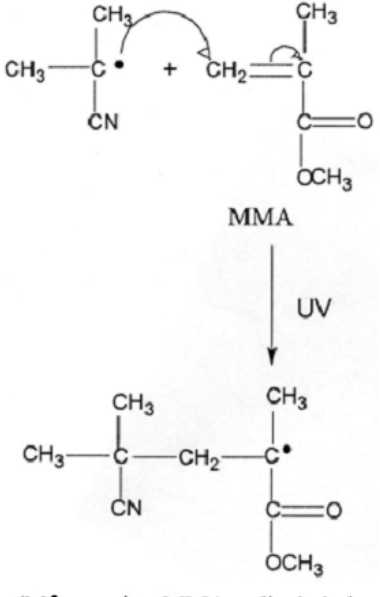
Figure 3. Growing MMA radical chain.